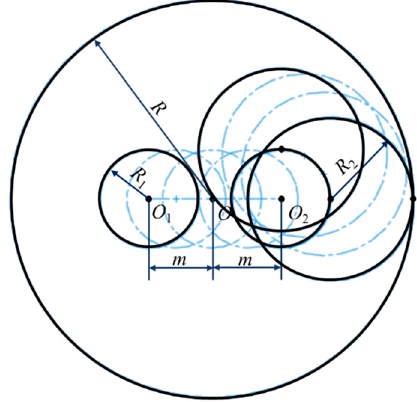
Figure 10. Reference coordinate system. Ignore the welding deviation between the cutter box and the cutter head. The theo- retical position deviation of fastening bolts is as follows.